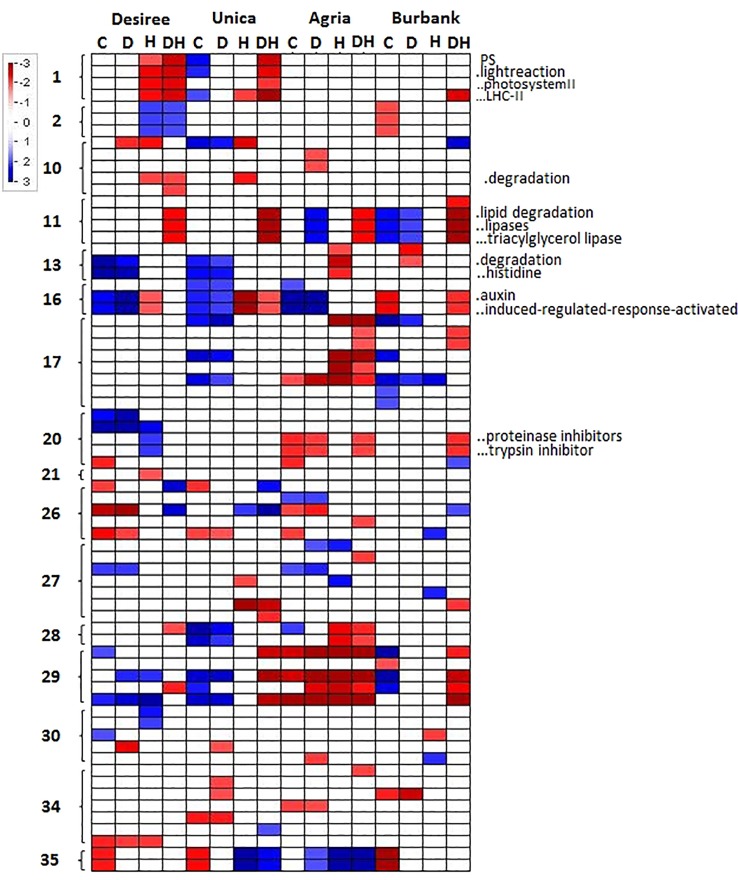
PageMan representation of significantly up or downregulated transcript ontologies in the subset of transcripts whose abundance exhibits significant variation in a genotype x treatment dependent manner. Transcripts were grouped according to their MapMan bin and transcript groups that exhibited a significant average change in abundance are indicated according to a color log2 scale as indicated. Absence of color indicates that average change in abundance for a specific MapMan bin were not significant for any given sample. Columns labels indicate genotype and treatment (C, control; D, drought; H, heat; DH, drought and heat). Row labels indicate the primary MapMan bin (1, photosynthesis; 2, major CHO metabolism; 10, cell wall; 11, lipid metabolism; 13, amino acid metabolism; 16, secondary metabolism; 17, hormone metabolism; 20, stress; 21, redox; 26, miscellaneous; 27, RNA; 28, DNA; 29, protein; 30, signaling; 34, transport; 35, not assigned). Shortened bin names of selected categories are indicated to the right of the figures.